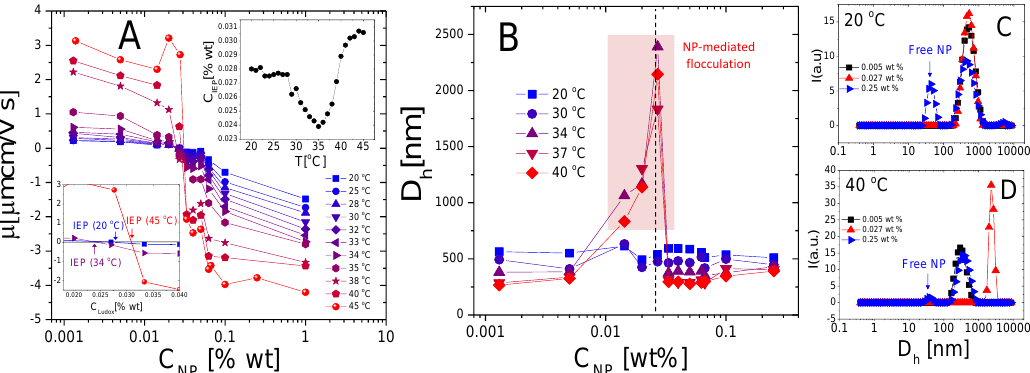
Figure 11. Electrophoretic mobility (Panel A ) and hydrodynamic diameter (Panel B ) of microgels in function of the co- suspended Ludox weight fraction for different temperatures as indicated in the panels. The insets in panel A show the concentration C IEP where electrophoretic mobility is zero as a function of temperature (top inset) and a zoom of the isoelectric region for three representative temperatures (bottom inset). Symbols within the shaded region in panel B refer to samples in which clustering at T > T c brought to the formation of sedimenting flocs. The vertical line corresponds to C IEP ( 40 ◦ C). Panels C and D show the intensity-weighted distribution obtained via the CONTIN analysis of the intensity correlation function g 2 ( τ ) -1 at 20 ◦ C and 40 ◦ C and three NP concentrations correspondent to poorly NP-decorated microgels, nearly neutralized microgels and overcharged microgels. As in PLL-microgel mixtures, NP-microgel complexation is characterized by both reentrant aggregation and charge reversal, however, in contrast to polyelectrolyte-microgel complexes, not all nanoparticles are adsorbed, even at T > T c , with a reduced mobility change.